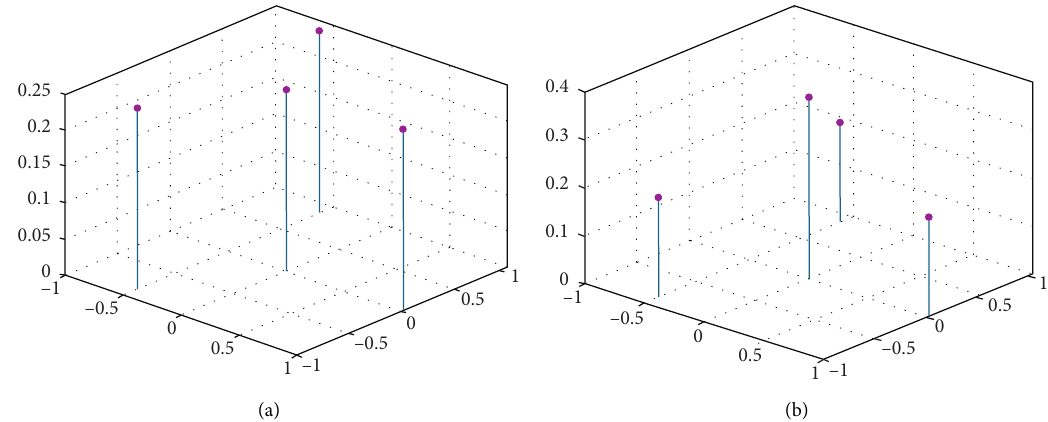
Figure 1: The probability distributions of (a) the normal (3, 1) signal and (b) the PS (3, 1) signal constellation positions.